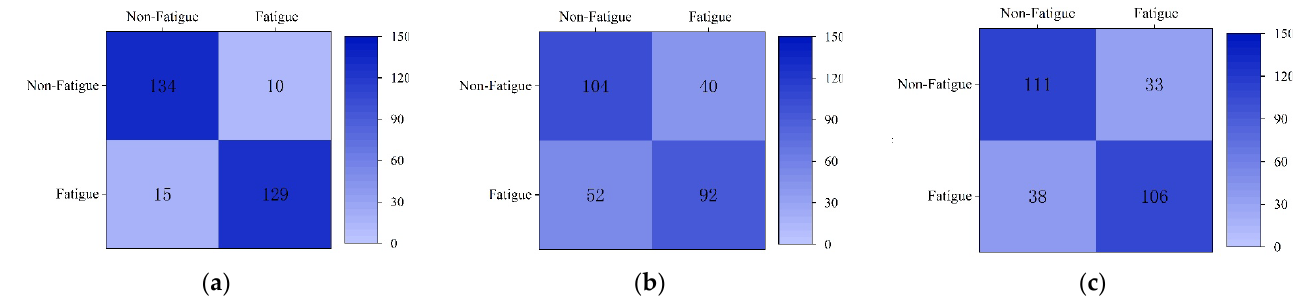
Figure 16. Confusion matrix of the three classification models. ( a ) SDAE; ( b ) LDA; ( c ) SVM. Table 7. Identification accuracy rates of models.